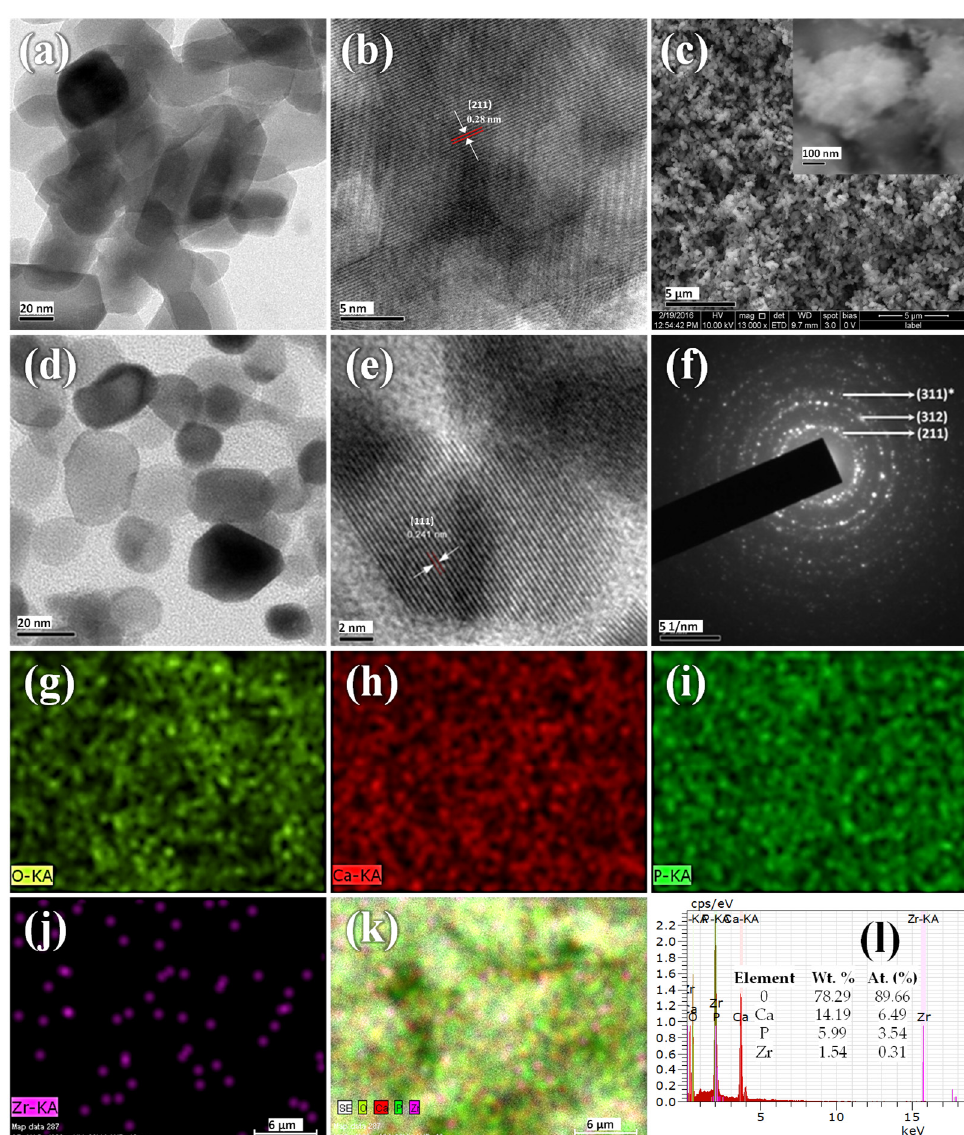
Figure 2. ( a ) TEM and ( b ) HRTEM images of pure HAp; ( c ) FESEM ( d ) TEM ( e ) HRTEM, and ( f ) SAED patterns of the HAp-Zirconia (HZ1) composite; ( g – k ) elemental mapping; and ( l ) energy dispersive spectrum with the percentage of chemical elements present in the HAp-Zirconia (HZ1) composite.